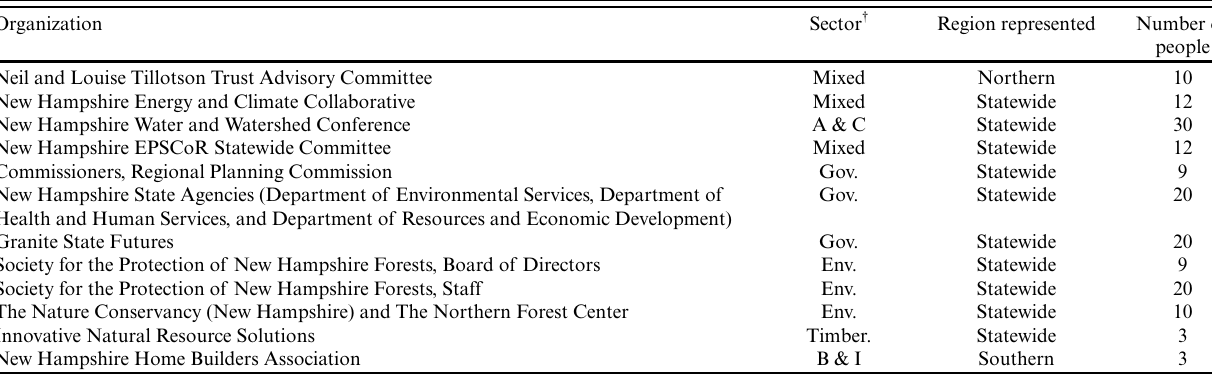
Table 1. List of organizations that were interviewed, with sector and number of people.